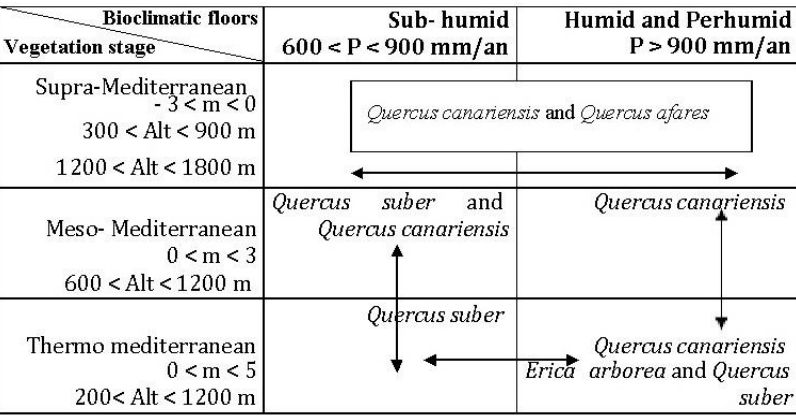
Fig. 2. Simplified diagram of the distribution of forest formations in the Guerrouche Forest